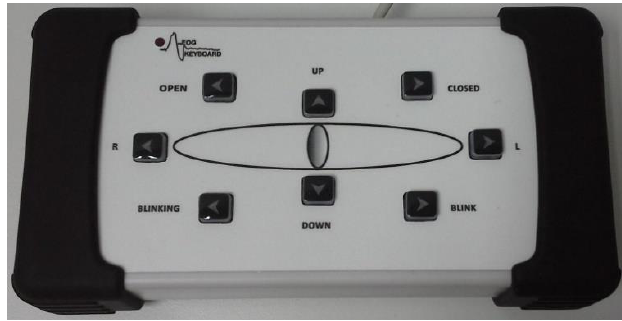
Figure 1. The front panel of the new device-each key indicates one artifact.